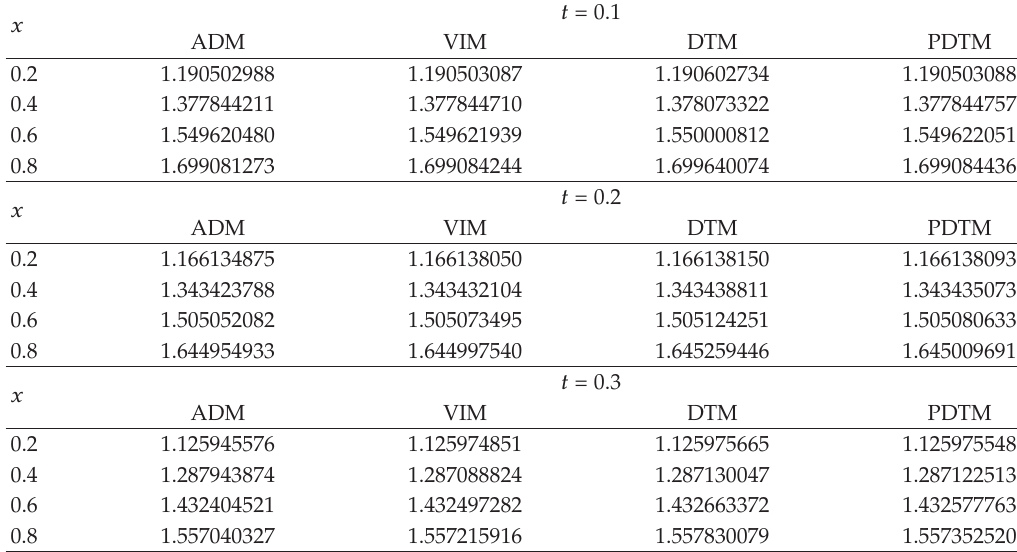
Table 2: Comparison for the approximate values obtained by ADM, VIM, DTM, and PDTM at various values of x and t